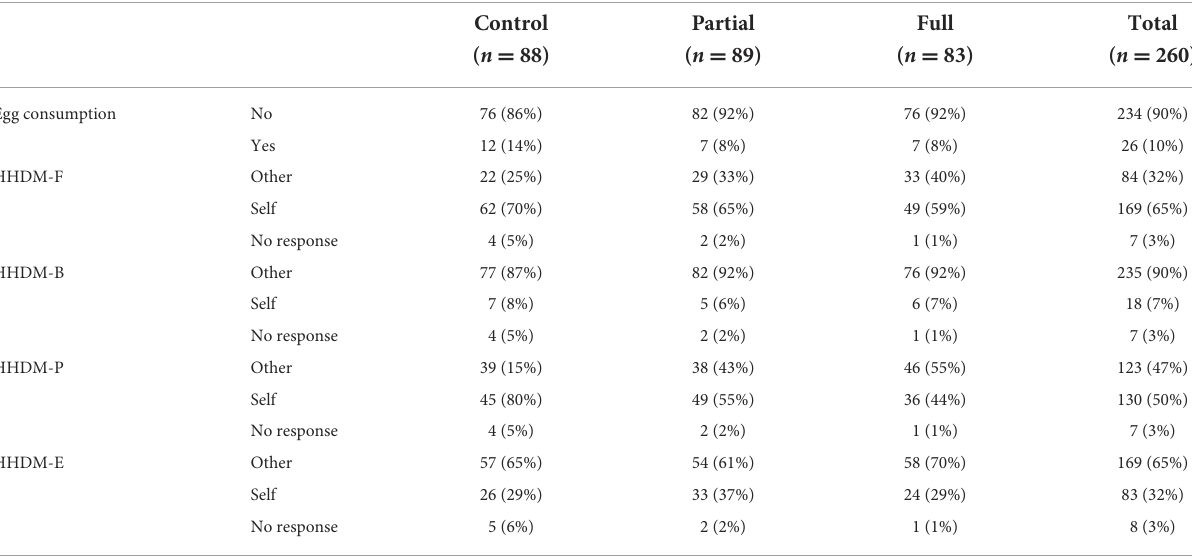
TABLE 1 Baseline summary statistics for the study